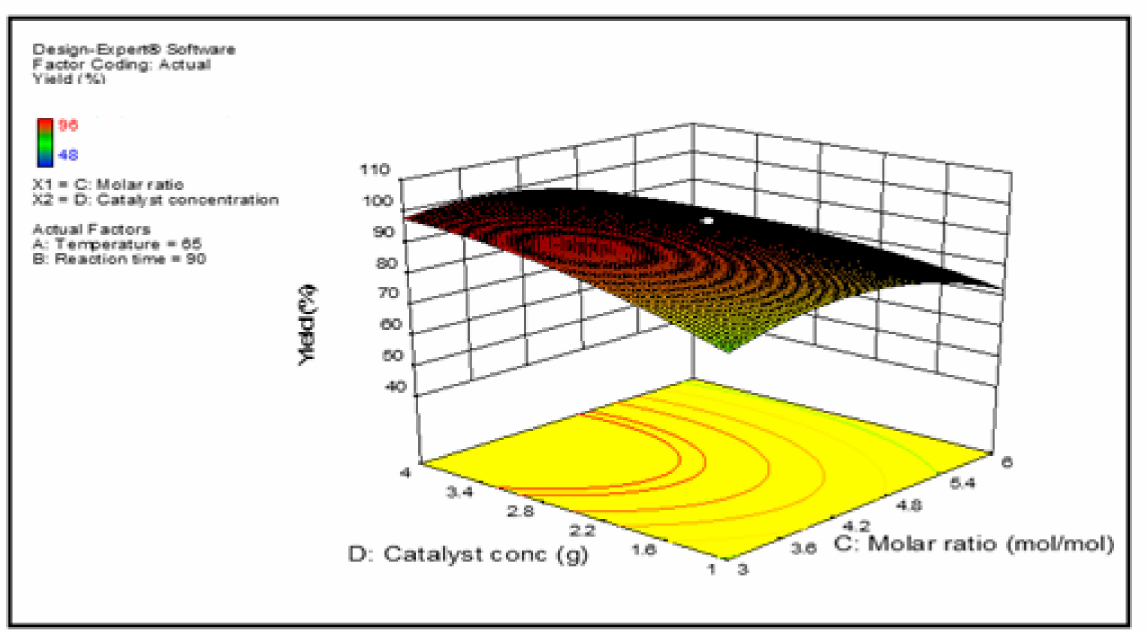
Figure 10. Projected biodiesel production against molar ratio and catalyst amount on a response surface 3D